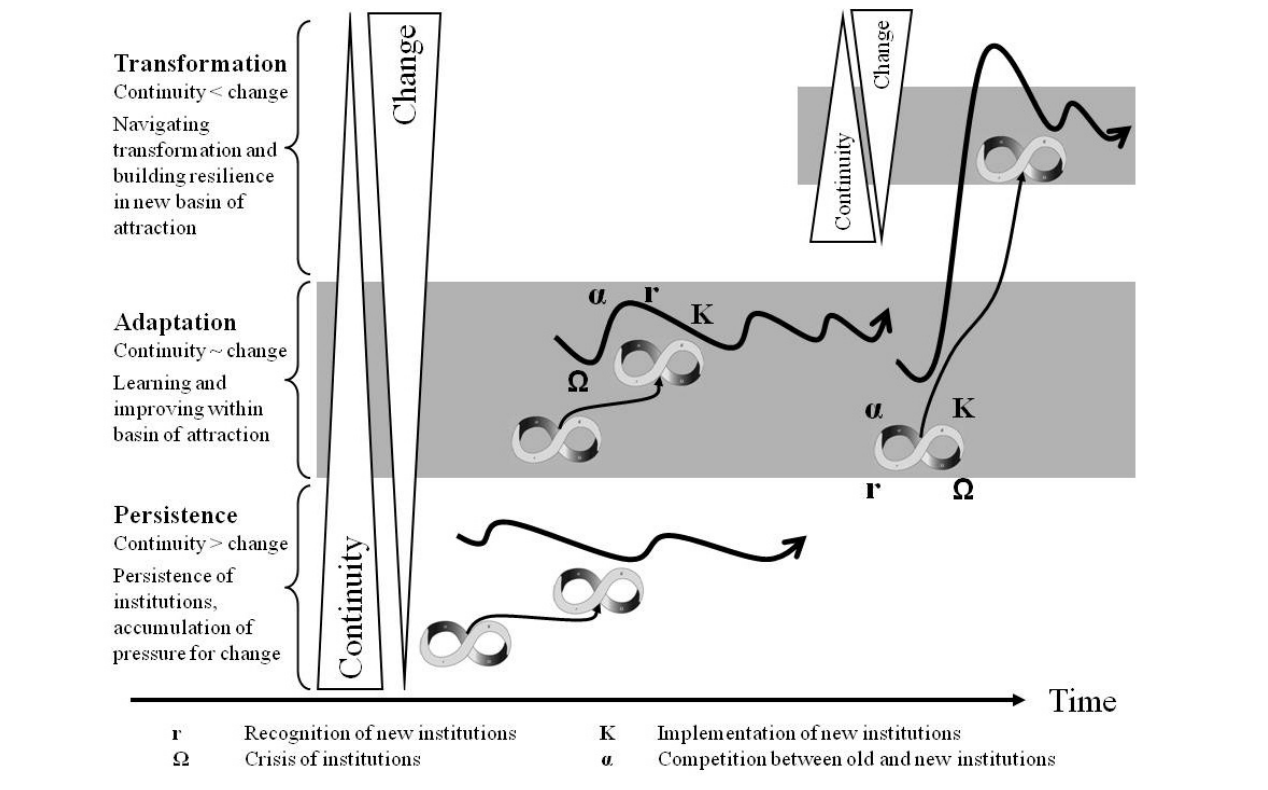
Fig. 1 . Persistence, adaptation, and transformation are often associated with different levels of continuity and change. The persistence of an institutional arrangement is characterized by a high level of institutional continuity. A setting of adaptation often reveals alternating phases of institutional continuity and change, while in transforming social-ecological systems, institutional arrangements undergo comprehensive